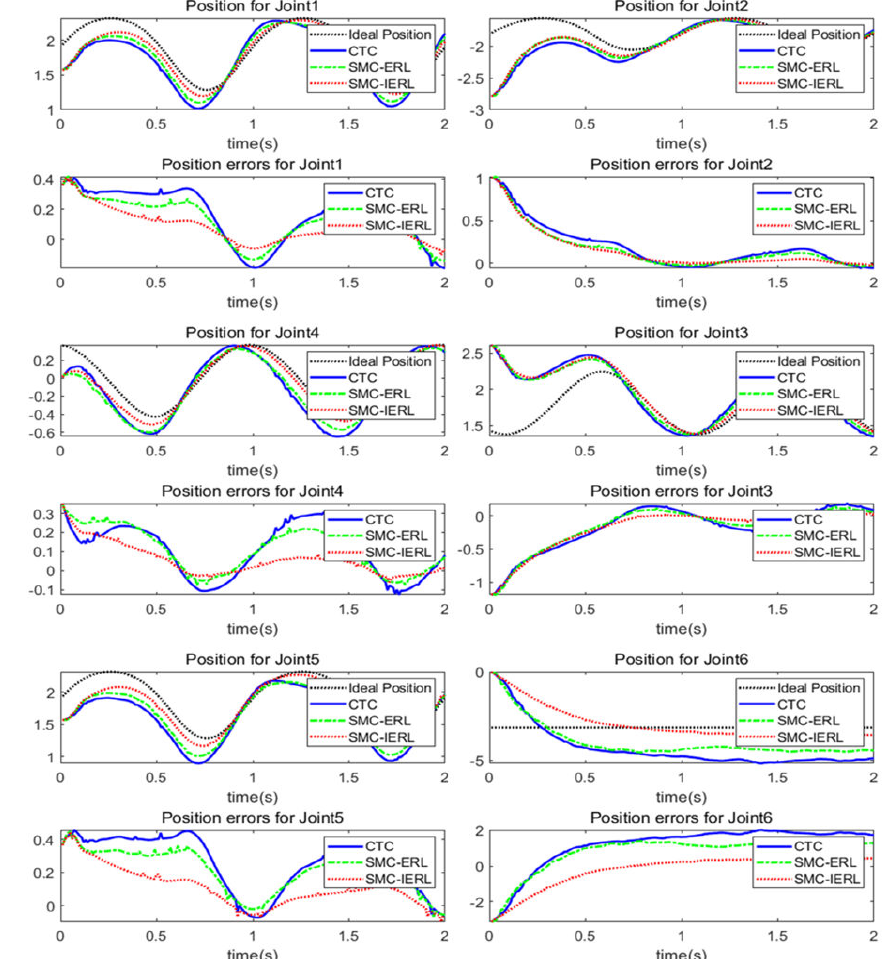
Figure 7. In the uniform circular trajectory experiment with disturbance signal, the expected po- sition of each joint is compared with the position and error of each joint obtained by the three control